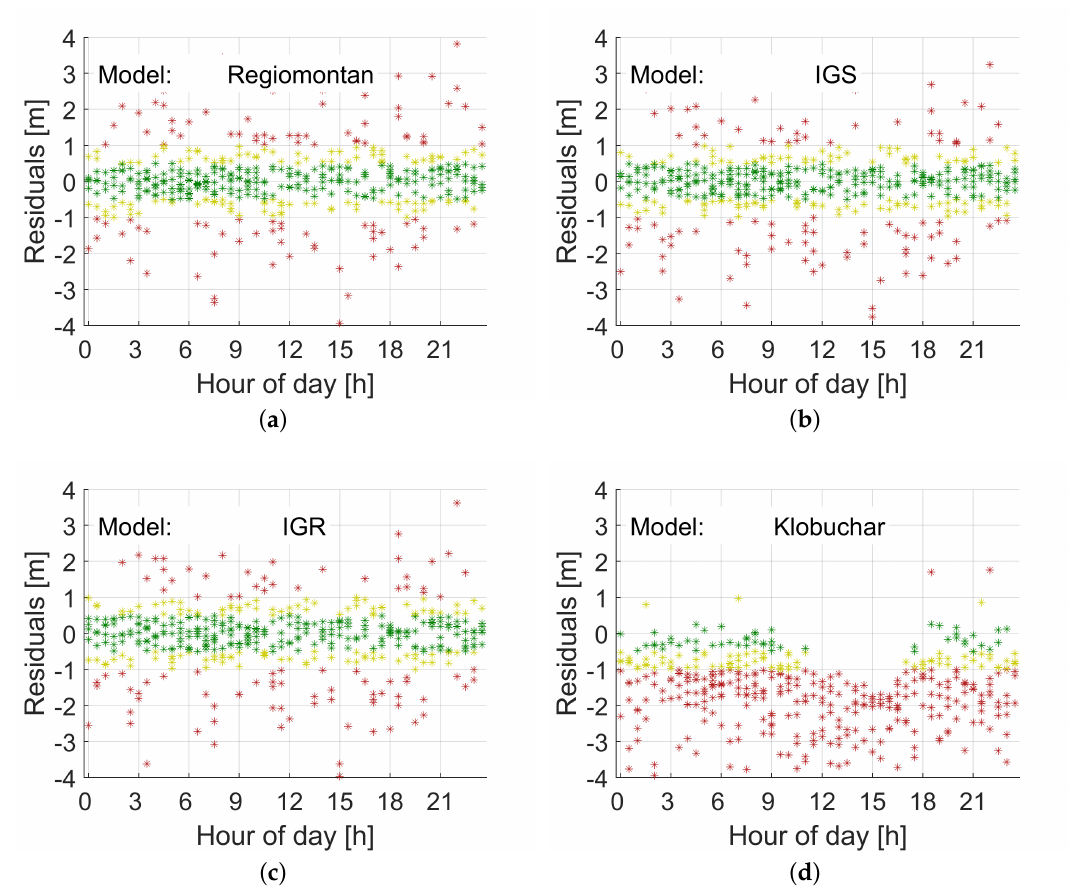
Figure 5. Range residuals for station WOFU on doy 335, 2019. Green indicates residuals smaller than 0.5m, yellow residuals smaller than 1 m, and red residuals larger than 1 m: ( a ) Regiomontan; ( b ) IGS final TEC grid (IGS); ( c ) IGS rapid TEC grid (IGR); and ( d ) Klobuchar. All four models yield the